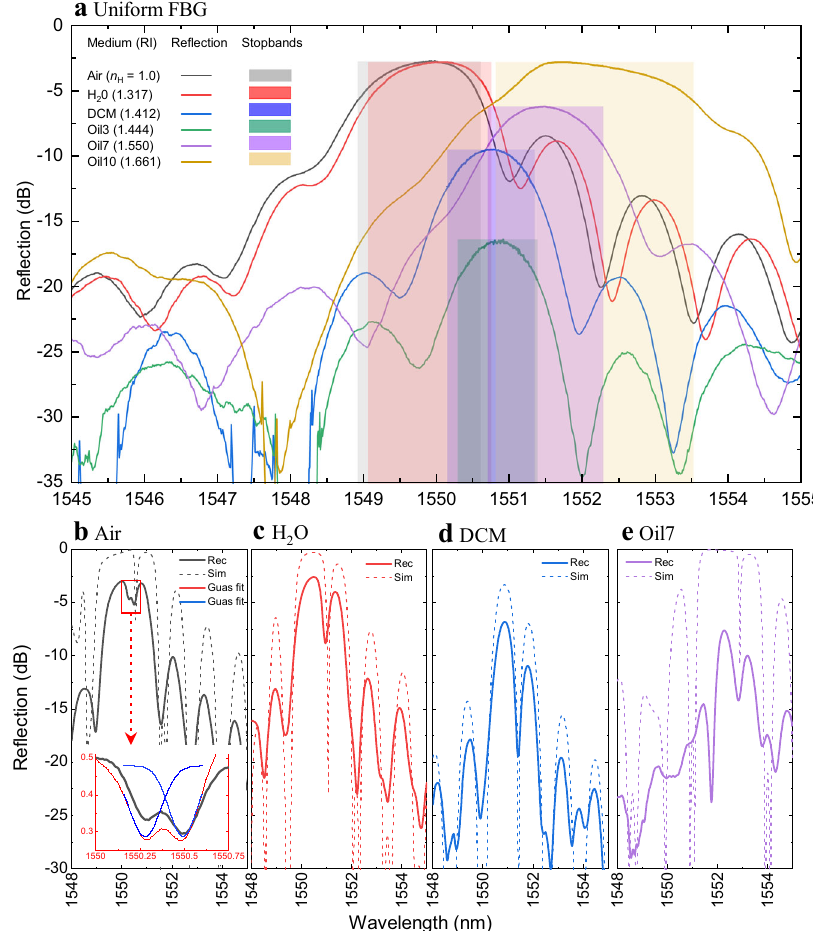
Fig. 4 Photonic stopband response of the FBGs fi lled with different materials. Re fl ection spectra ( a ) recorded from a uniform FBG of 600 nanoholes ( E pulse = 4.5 µ J, Ʌ = 1072 nm, 2 mm plate) forming strong (3 dB) and wide (~2 nm) stopbands when fi lled with low ( n H = 1) or high ( n H = 1.661) refractive index materials. The coloured bands mark the 3 dB bandwidth. Refractive index matching oil ( n H = 1.448) dramatically weakens the stopband. Re fl ection spectra (solid lines) of unpolarized light ( b – e ) were recorded from a π -shifted FBG of 1200 nanoholes for four different examples of RI values ( n H by colour from legend a ) and comparison with simulated spectra for P -polarised light (dashed lines). Laser-induced birefringence of δλ = 210 pm is resolved for the air- fi lled case ( b inset). Gaussian line fi ts of the π -defects (blue and red lines in b inset) provide ±10 pm spectral − 2.72 dB re fl ection with air to − 17.28 dB with Oil5 ( n = 1.448), H marks the matching condition on RI, beyond which higher RI = 1.661, Fig. 4a) regenerated strong stopbands (i.e., Oil10, n H ( − 2.76 dB).